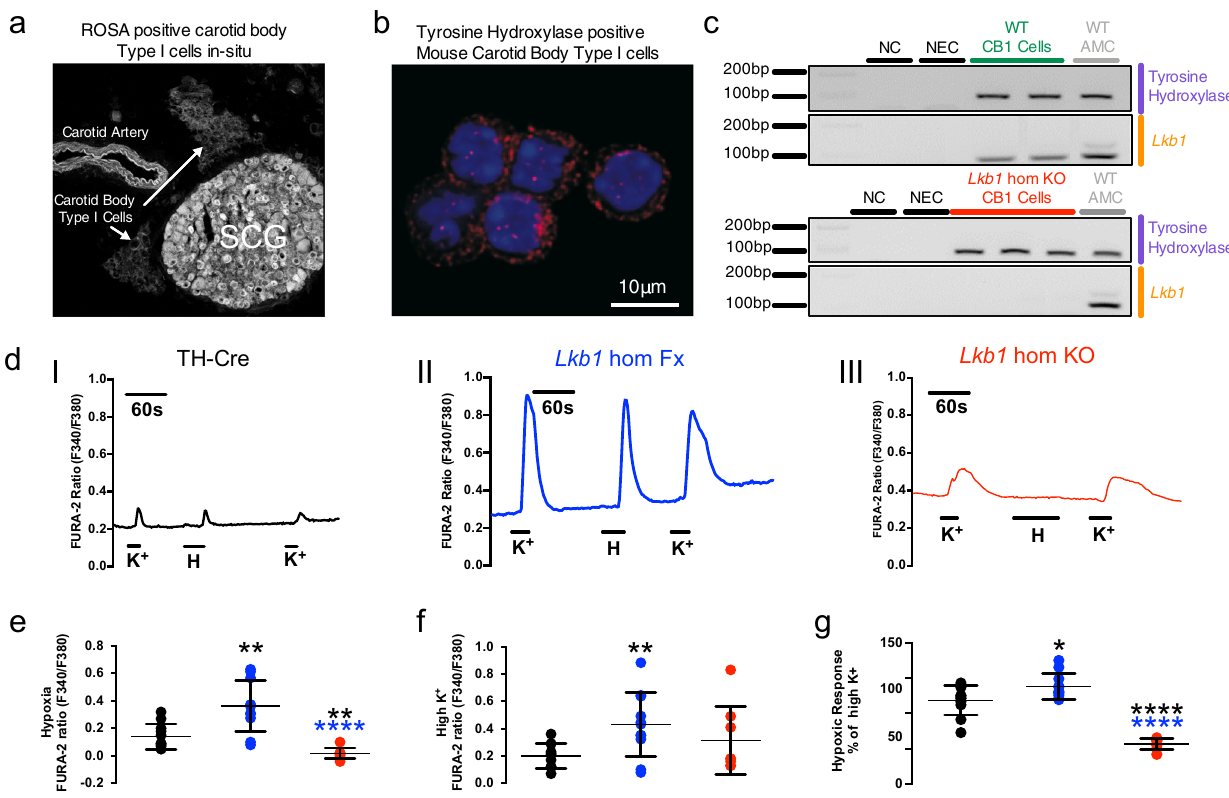
Fig. 1 Conditional deletion of Lkb1 in carotid body type I cells blocks hypoxia-evoked calcium transients. a Confocal image shows tdTomato (excitation 555 nm, emission 582 nm) positive type I cells in situ within a section of tissue comprising the carotid body, superior cervical ganglion (SCG) and carotid artery; note endothelial cells and sympathetic neurons express tyrosine hydroxylase (TH). b Acutely isolated carotid body type I cells stained for TH and DAPI. c Single-cell end-point RT-PCR amplicons for TH and Lkb1 from acutely isolated adrenal medullary chromaf fi n cells (WT AMCs) and carotid